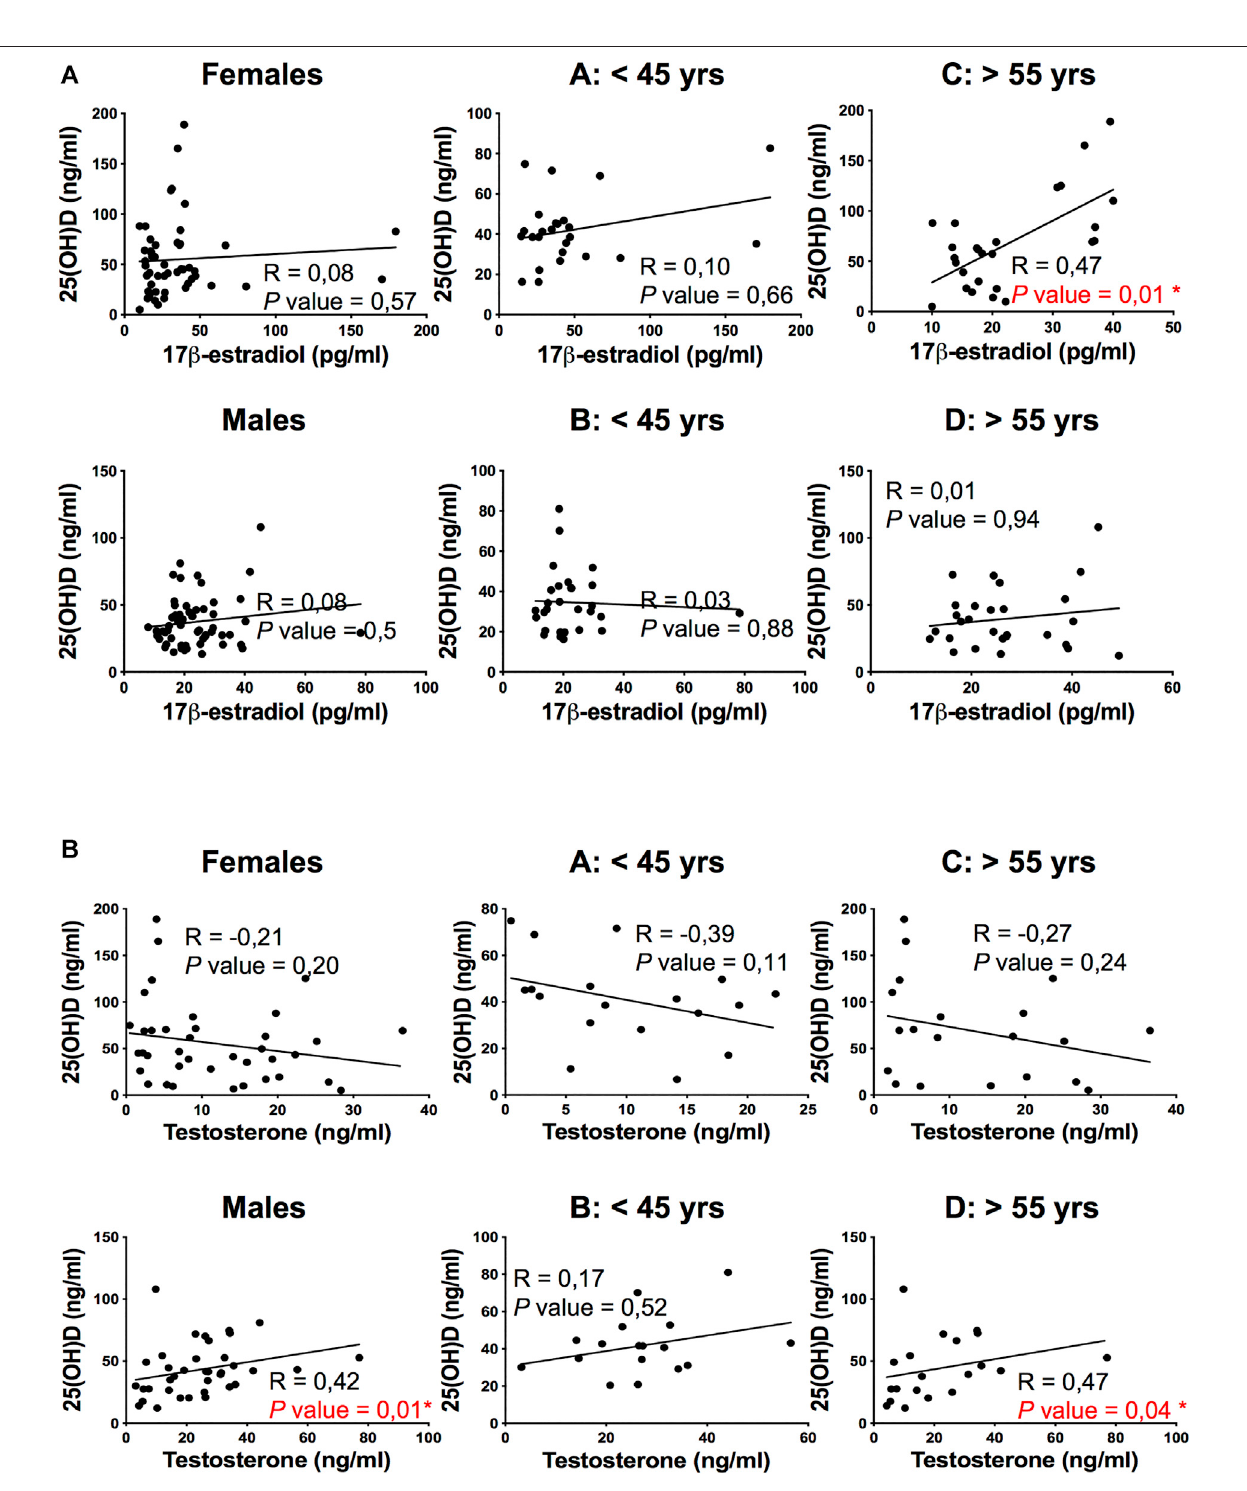
FIGURE 2 | Correlationofplasma25(OH)vitaminDlevelswith17 β -estradiolandTestosteroneinCOVID-19patients. (A) Correlationandlinearregressionanalysisofplasma levelsof25(OH)Dand17 β -estradiolinfemaleandmalepatientscategorizedintofourgroups:A,40pre-menopausalfemalesunder45years(A: < 45yrs);B,40malesunder45years (B: < 45yrs);C,40post-menopausalfemalesover55years(C: > 55yrs);D,40malesover55years(D: > 55yrs).Asigni fi cantlypositivecorrelationbetweenplasmalevelsof25(OH)D and17 β -estradiolisobservedinsubgroupC. (B) Correlationandlinearregressionanalysisofplasmalevelsof25(OH)Dandtestosteroneintofourgroups.Asigni fi cantlypositive correlation between plasma levels of 25(OH)D and testosterone levels is observed in males and in subgroup D. The Spearman's rho (R) and P values were determined using the Spearman's rank correlation analysis. Solid lines represent best fi ts as estimated by linear by linear regression analysis. *, P < 0.05 was considered statistically signi fi cant.